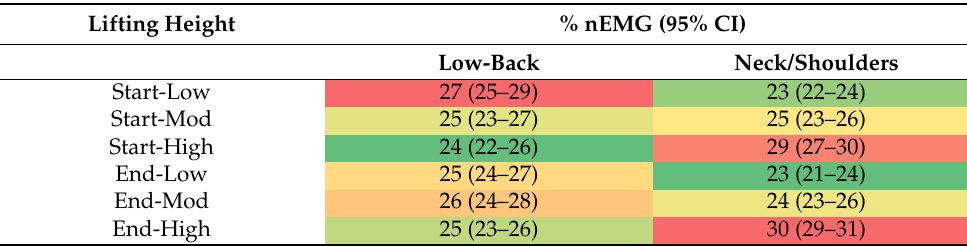
Muscular workload estimates color graded from green to red, with lower estimates marked as nuances of green and higher estimates marked as nuances of red. The analyses were mutually controlled for each predictive variable, participant age, sex, and muscle. Table 3. Muscular workload by lifting start and end position. Estimates are presented as % nEMG (95% CI).